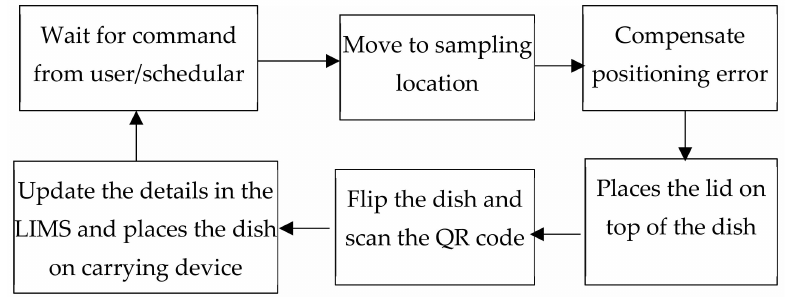
Figure 6. Task flow diagram of the experiment using Petri dishes.